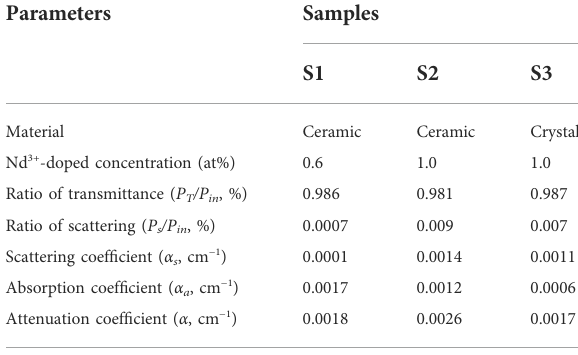
TABLE 1 Measured values and correlative results at 1,064 nm of different samples. Parameters Samples